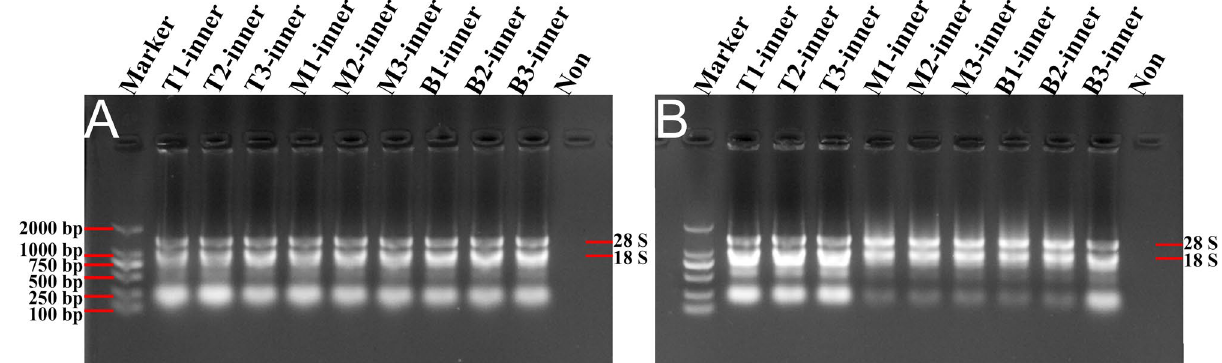
Figure 5. Gel images of total RNA from inner scales of Lilium lancifolium Thunb. and Lilium brownii var. viridulum Baker isolated using the modified TRIzol method. The RNA samples extracted by the modified TRIzol method were separated and analyzed in 1% agarose gels, respectively. Then the gels were visualized and exposed by Gel Imager System in different fields, and pictures were taken, respectively. The order of samples of each gel lane is as follows: ( A ) Lane 1: DL2000 DNA marker; Lanes 2–4 are RNA isolated from top scales of Lilium lancifolium Thunb.; Lanes 5–7 are RNA isolated from middle scales of Lilium lancifolium Thunb.; Lanes 8–10 are RNA isolated from basal scales of Lilium lancifolium Thunb.; Lane 11: Loading buffer solution without RNA to serve as a control; ( B ) Lane 1: DL2000 DNA marker; Lanes 2–4 are RNA isolated from top scales of Lilium brownii var. viridulum Baker; Lanes 5–7 are RNA isolated from middle scales of Lilium brownii var. viridulum Baker; Lanes 8–10 are RNA isolated from basal scales of Lilium brownii var. viridulum Baker; Lane 11: Loading buffer solution without RNA to serve as a control . 28S and 18S represent the location of 28S and 18S rRNA bands.